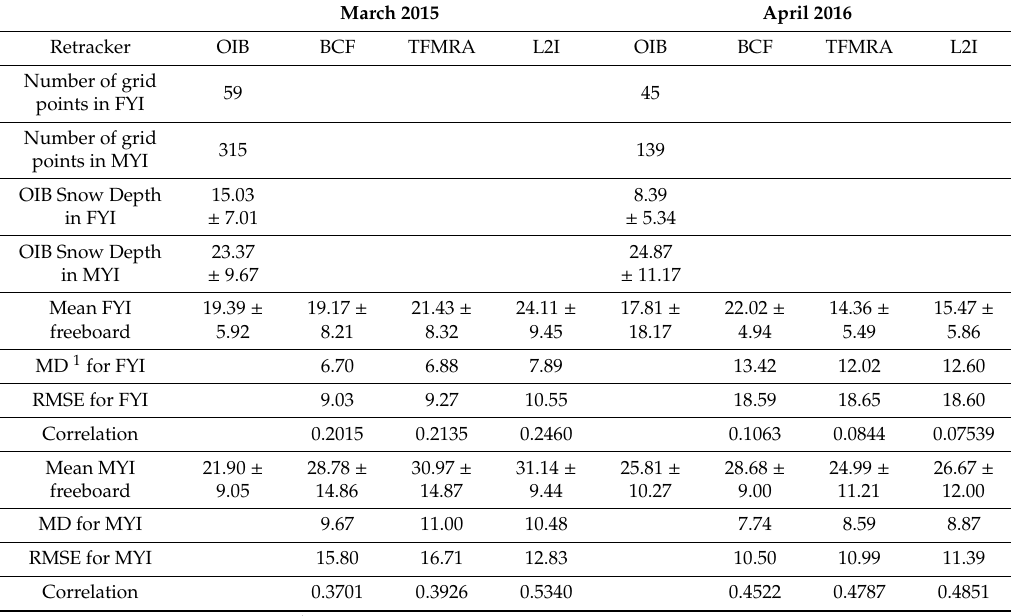
Figure 4. Probability density function of sea ice freeboard from the BCF, TFMRA, CS-2 L2I products and OIB data in March 2015 ( a ) and April 2016 ( b ). Probability density function of ice freeboard di ff erence between BCF, TFMRA, and CS-2 L2I products compared to OIB in March 2015 ( c ) and April 2016 ( d ). Table 6. The ice freeboard retrievals from the BCF, TFMRA, and CS-2 L2I products are compared with OIB data for first-year ice (FYI) and multi-year ice (MYI) in March 2015 and April 2016. Unit: cm. Snow data were obtained from the airborne OIB